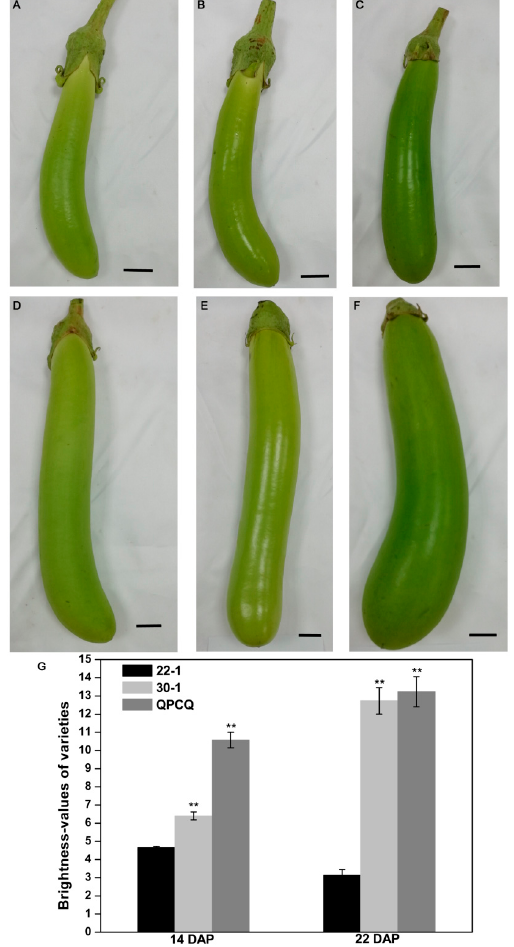
Figure 1. Eggplant fruits with glossy and dull peel at different development stages. The 14-day-pollinated fruits of 22-1 ( A ), 30-1 ( B ), and QPCQ ( C ). The 22-day-pollinated fruits of 22-1 ( D ), 30-1 ( E ), and QPCQ ( F ). Scale bar = 20 mm. ( G ) Brightness values of the three varieties at 14 DAP and 22 DAP. Three fruits of each variety were used to measure brightness values. Asterisks indicate a sig- nificant difference of 30-1 and QPCQ against 22-1 in brightness values (** p < 0.01).